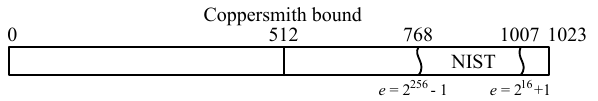
Figure 3: RSA-2048 bit-recovery bounds of n for different e